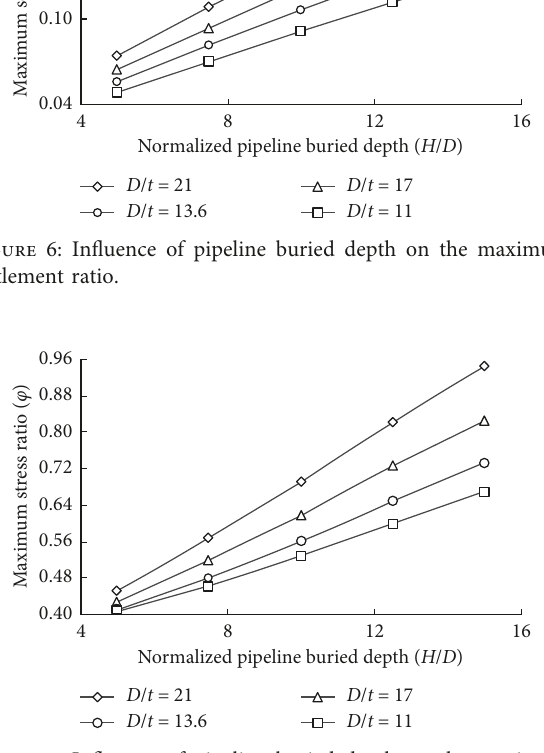
Figure 7: Influence of pipeline buried depth on the maximum stress ratio.